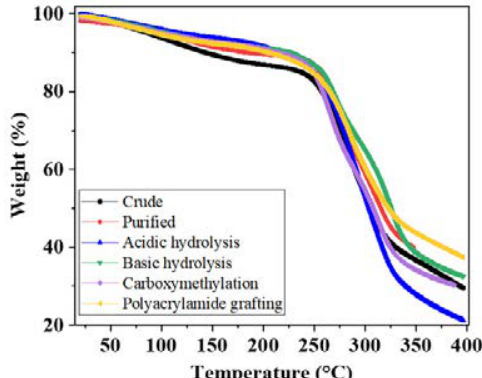
Fig. 4. Thermogravimetric analysis of A. modesta crude